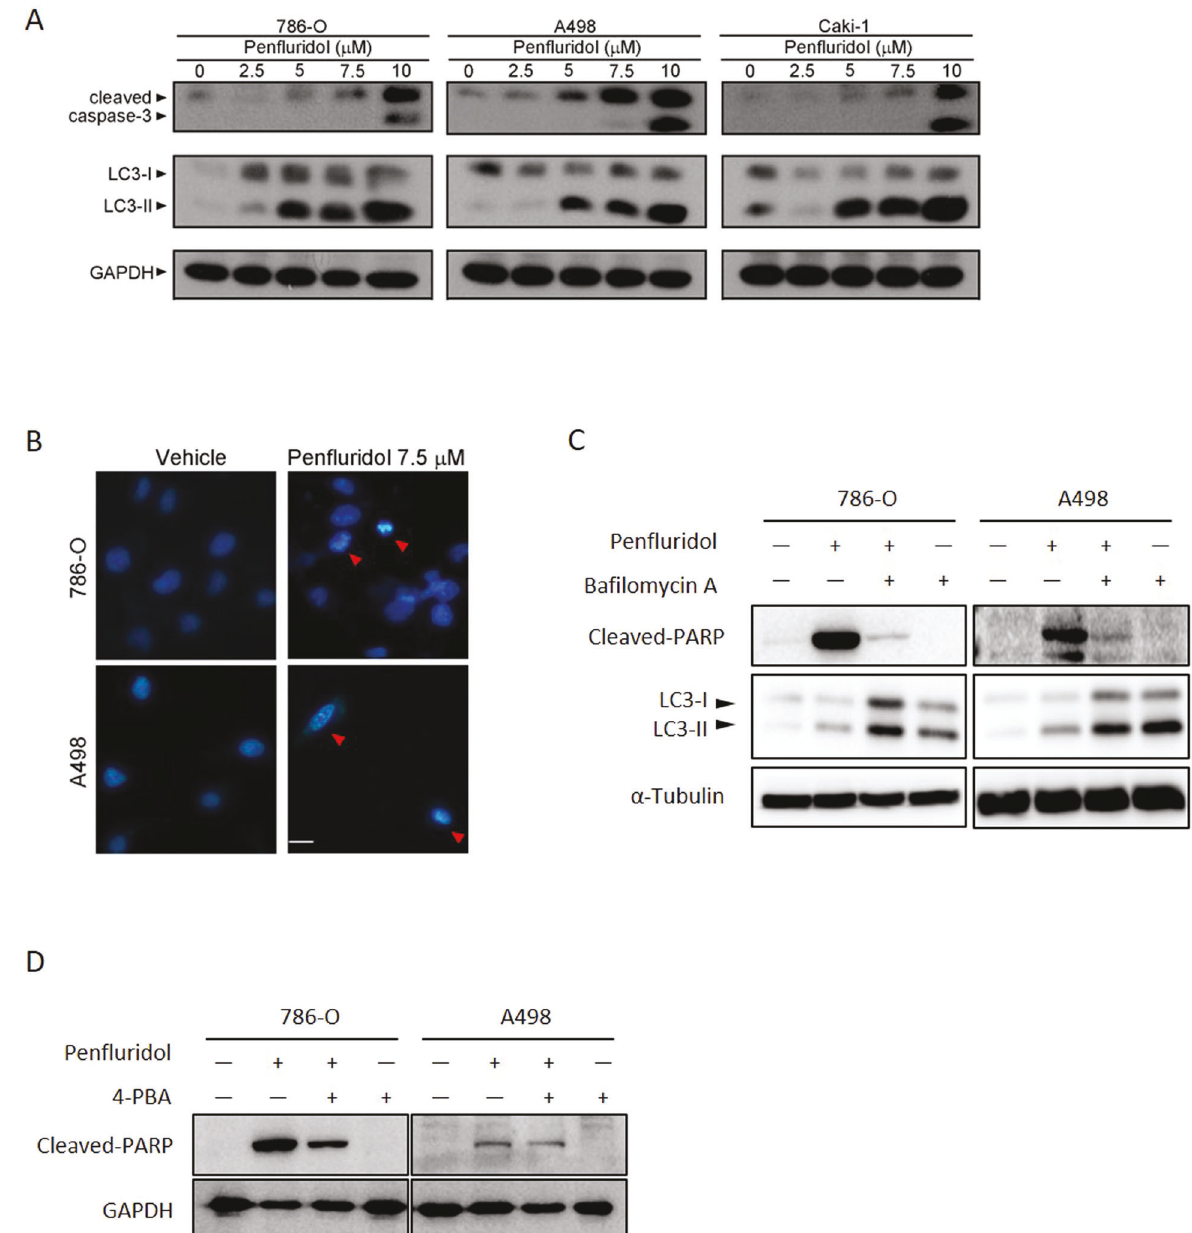
Fig. 3 Coordinated regulation of autophagy and apoptosis is involved in the death-inducing effects of pen fl uridol in clear cell renal cell carcinoma (ccRCC) cells. A 786-O, A498, and Caki-1 cells were treated with the indicated concentrations of pen fl uridol for 24 h. Cell lysates were probed with antibodies against cleaved caspase-3 and LC3. B A498 and 786-O cells were treated with 7.5 μ M pen fl uridol for 24 h, and nuclear fragmentation and condensation (red arrows) as indicators of apoptosis were analyzed by fl uorescence microscopy after Hoechst 33342 staining (scale bar: 50 μ m). C A498 and 786-O cells were pretreated with 20 nM of Ba fi lomycin A for 1 h followed by pen fl uridol (7.5 μ M) treatment for 24 h. Expression levels of LC3 and cleaved poly(ADP ribose) polymerase (PARP) were detected by a Western blot (WB) analysis. D 786-O (left panel) and A498 (right panel) cells were pretreated with or without 4-phenylbutyric acid (4-PBA) (1 mM) for 1 h, followed by pen fl uridol (7.5 μ M) treatment for 24 h. Cleaved PARP in both cells were detected by a WB analysis. GAPDH or α -Tubulin were used as an equal loading